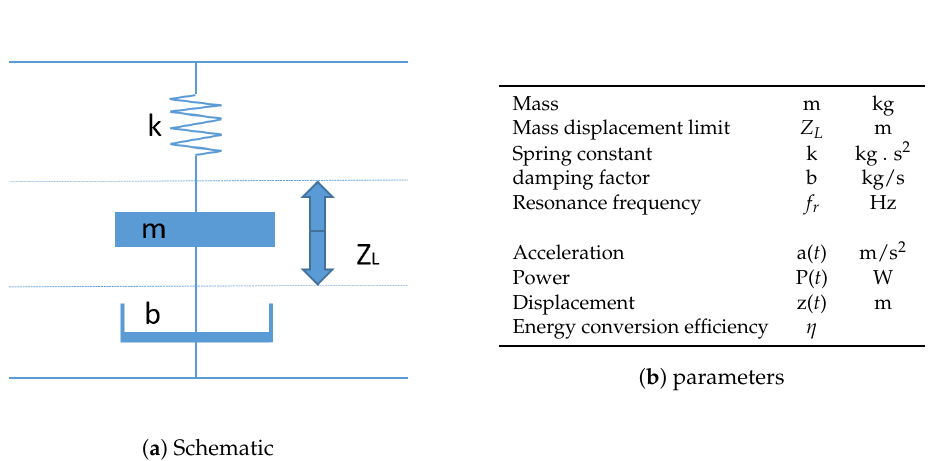
Figure 7. Second-order mass-spring model and associated parameters of a velocity-damped resonant